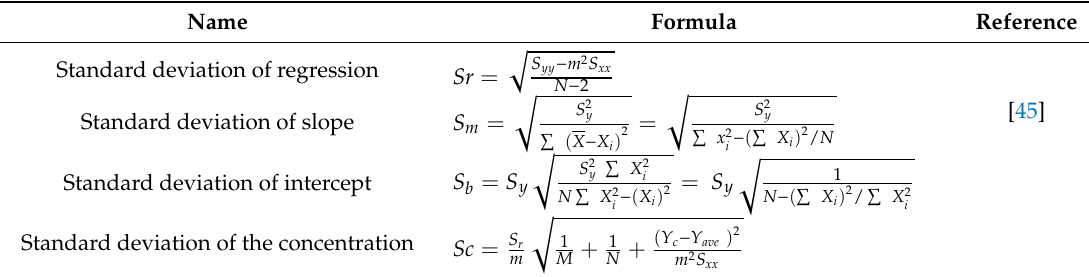
Table 3. Calculation formula of measurement